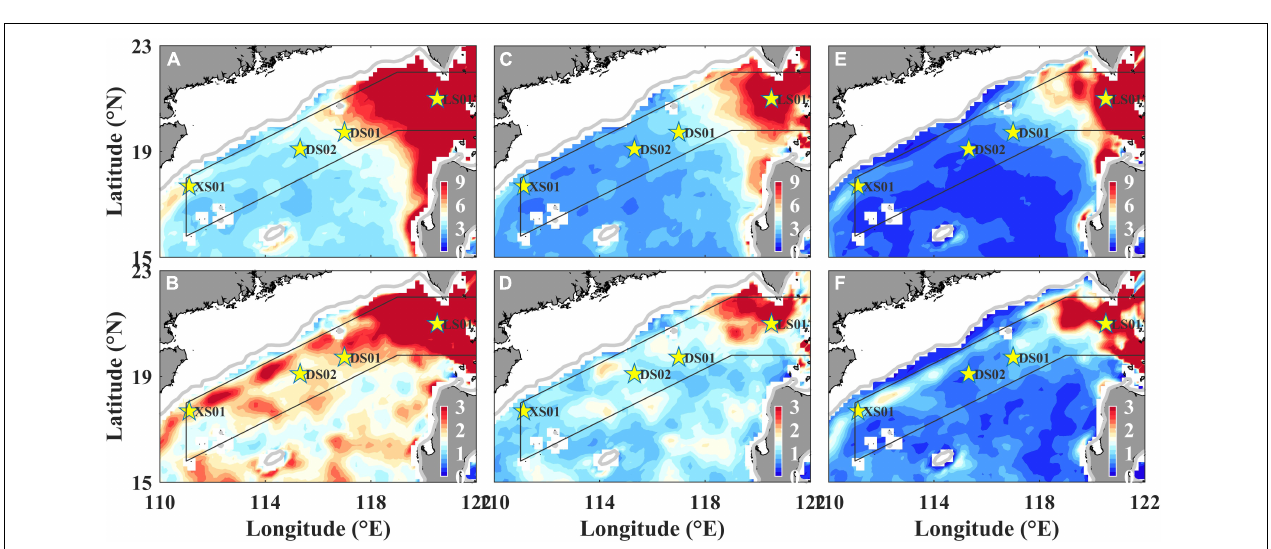
FIGURE 10 | Horizontal distribution of vertical integrated energy. (A) Eddy potential energy (EPE) in 10–65-day period (m 3 /s 2 ); (B) EPE in 65–110-day period (m 3 /s 2 ); (C) Eddy kinetic energy (EKE) in 10–65-day period (m 3 /s 2 ); and (D) EKE in 65–110-day period (m 3 /s 2 ) averaged from January 2003 to December 2012.